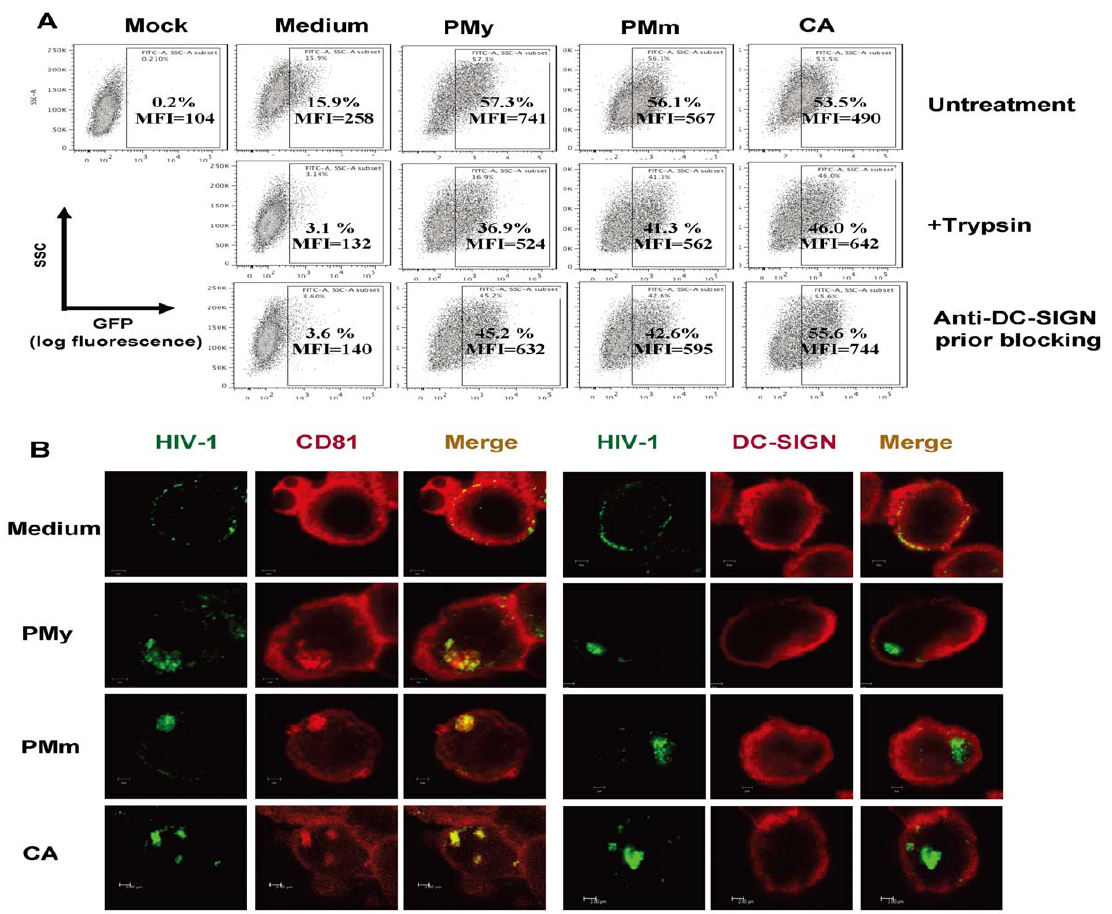
Figure 4. Fungus-treated MDDCs enhance HIV-1 endocytosis and alter viral intracellular sequestration. (A) Enhanced HIV-1 endocytosis in Fungus-treated MDDCs. Immature MDDCs were treated with heat-killed fungi as described above. HIV-1 VLPs (40 ng amounts of p24 gag ) were added for 2 h incubation, and some samples were prior-blocked with anti-DC-SIGN antibodies, and trypsin treatment for 5 min at room temperature was used to remove surface-bound virus. Gag-GFP level was detected by flow cytometry, and the positive percentages and the calculated MFI values from one representative out of four experiments are denoted. (B) Internalized HIV-1 VLPs are sequestrated in CD81 + DC-SIGN - compartments in fungus-stimulated MDDCs. Immature MDDCs were treated with heat-killed fungi and pulsed with HIV-1 VLPs as described for panel A, MDDCs were fixed and immunostained for DC-SIGN or CD81, and cells were observed by confocal microscopy. Scale bars, 2 m m.